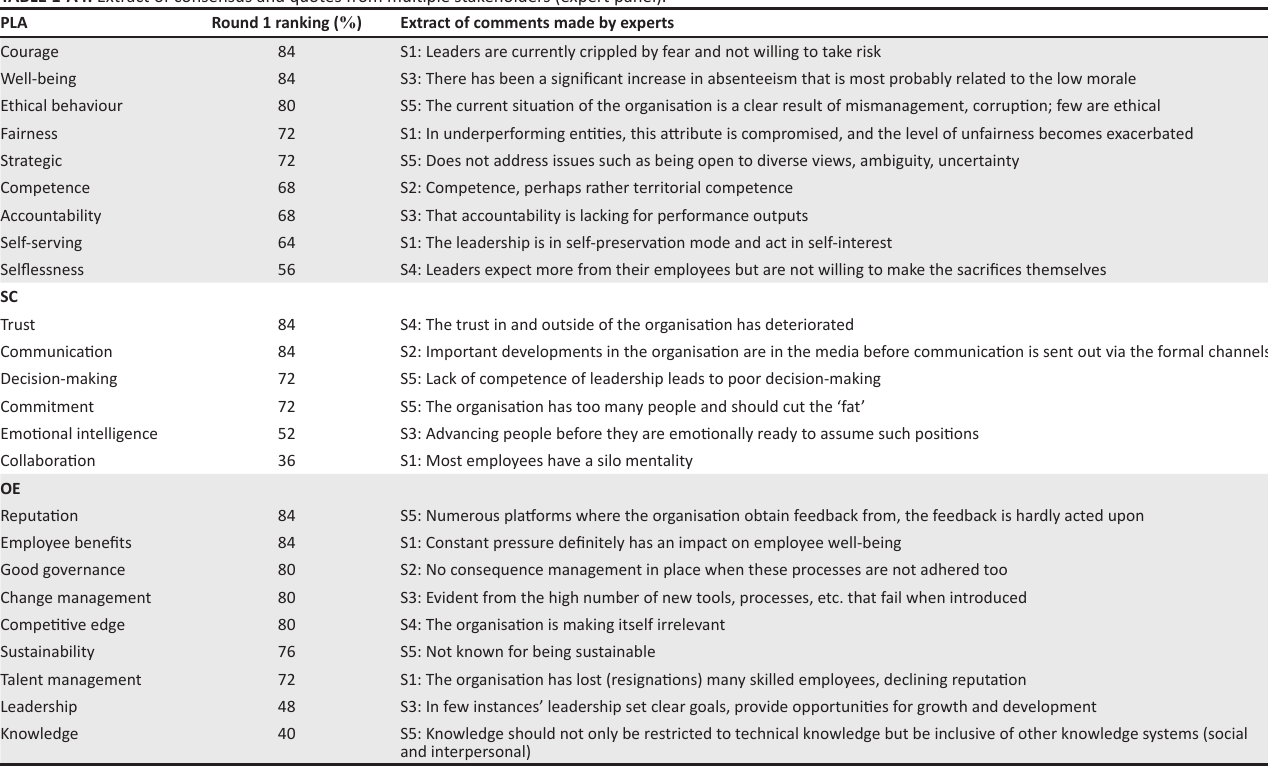
TABLE 1-A4: Extract of consensus and quotes from multiple stakeholders (expert panel).